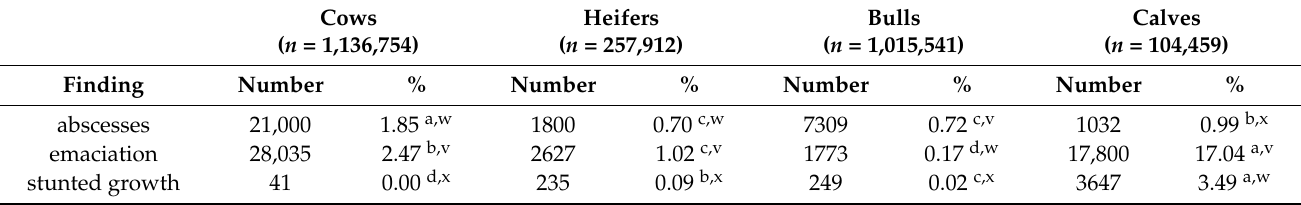
Table 6. Comparison of the incidence of overall changes in cows, heifers, bulls and calves slaughtered in slaughterhouses.